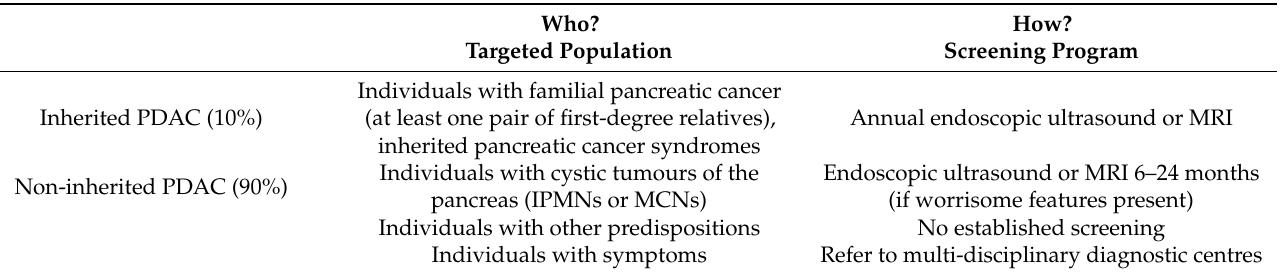
Table 2. Existing screening programs for pancreatic cancer in high-risk